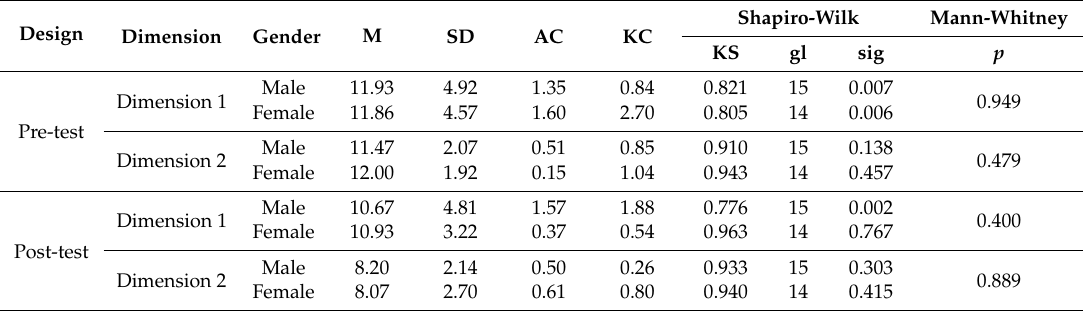
Table 7. Comparison in the post-test and pre-test design of the experimental group, with respect to